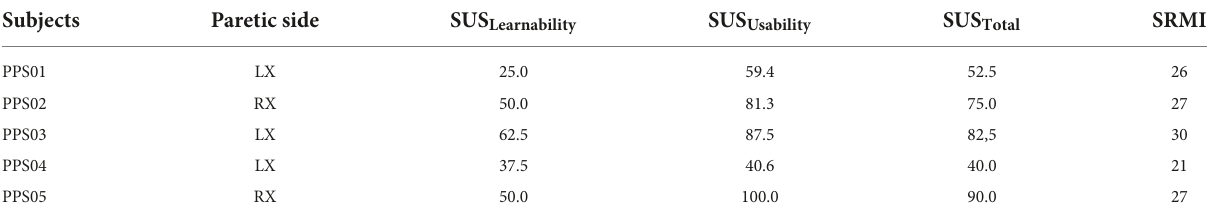
TABLE 7 SUS scale and its subscores and SRMS scale reported from person post-stroke which tested the final version of TWIN-Acta (T2). Subjects Paretic